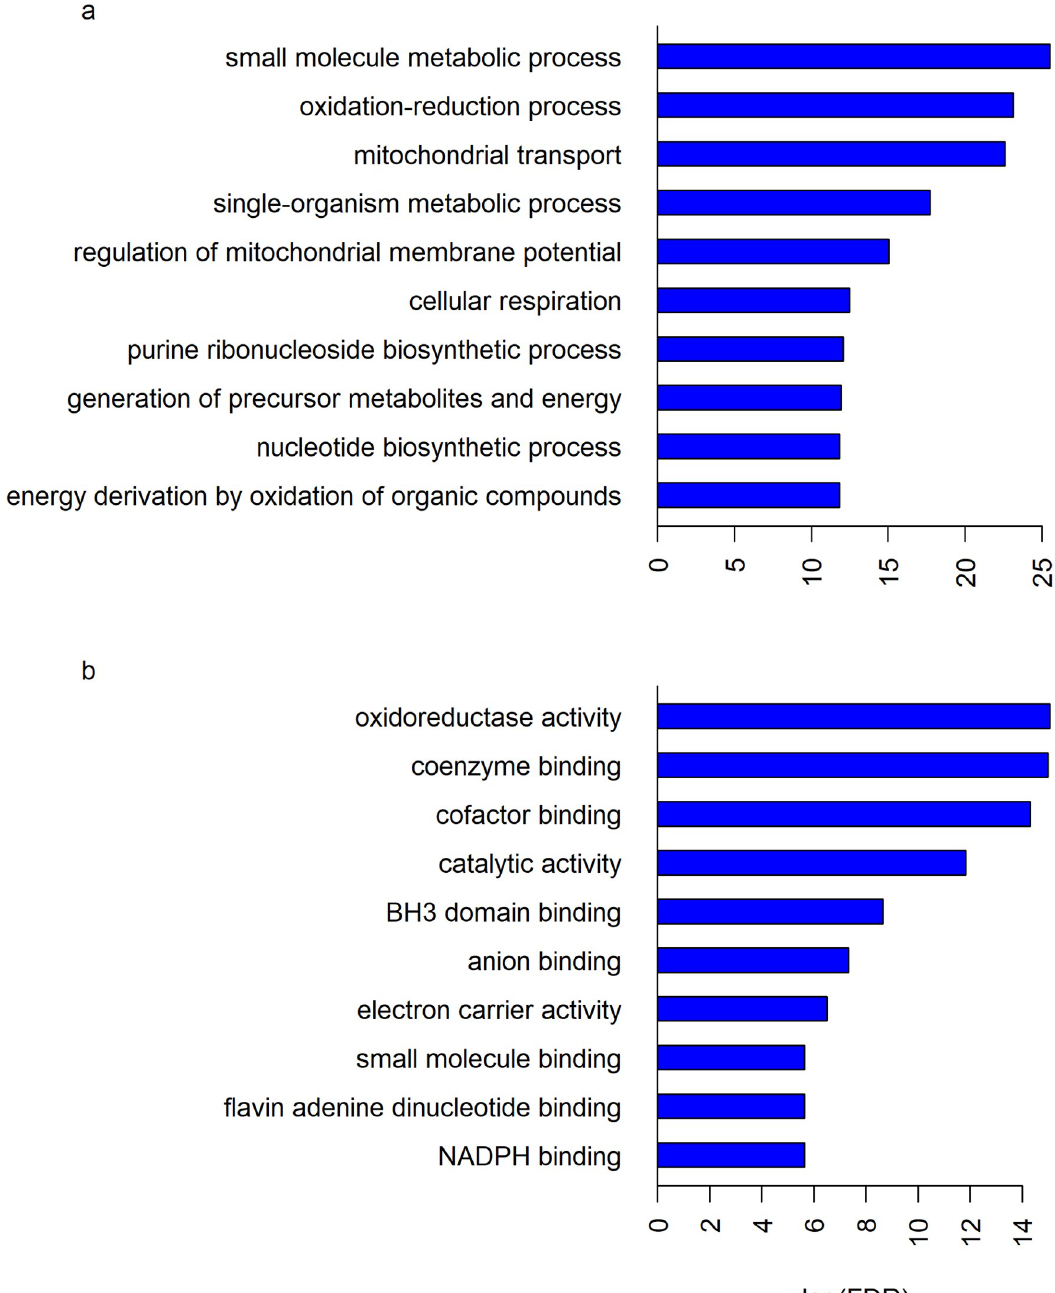
Fig 4. Some of the significantly enriched (a) BP and (b) MF GO terms. Each GO term was plotted against the negative logarithm of its false discovery rate (FDR) obtained from GO analysis using the STRING database, which uses hypergeometric test for determining significantly enriched GO terms